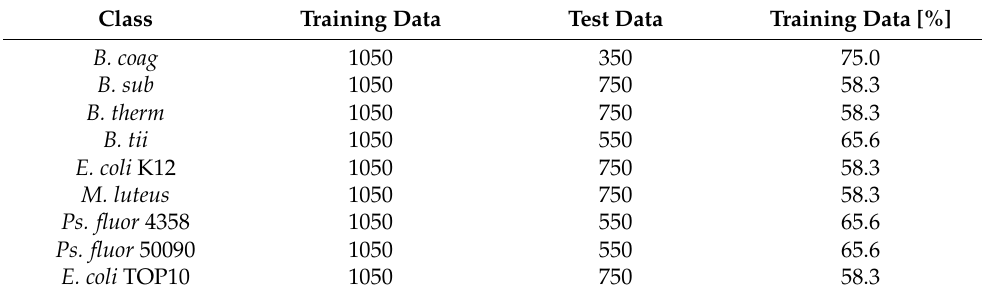
Table 1. Training and test data set sizes and data splitting ratio for the trained and tested microorganisms.